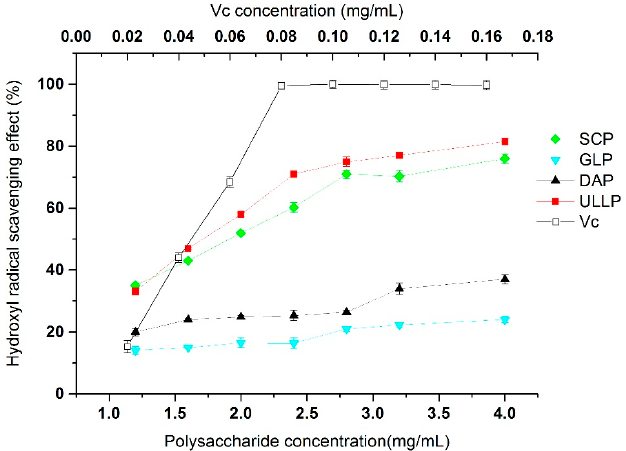
Figure 5. Hydroxyl radical scavenging activities of GLP, DAP, ULLP, SCP, and Vc. GLP, DAP, SCP, and SCP are polysaccharides extracted from G. lemaneiformis , D. antarctica , S. ceylonensis , and Ulva lactuca L., respectively.